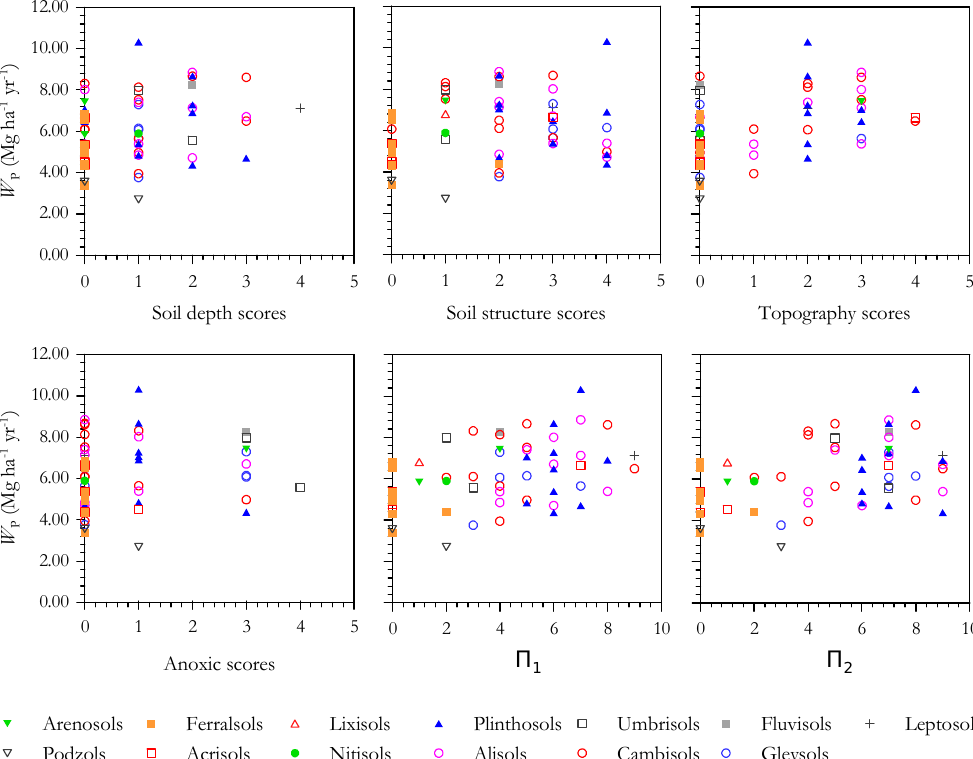
Fig. 4. Relationships between above-ground coarse wood production ( W P ) and soil physical properties. For definitions of 5 1 and 5 2 see Sect.